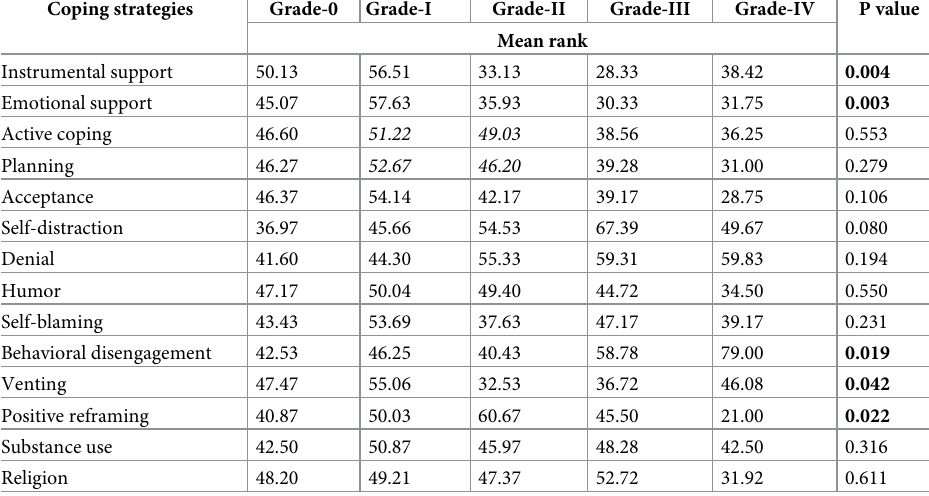
Kruskal-Wallis H test was done; Higher mean rank indicates more adoption of the respective strategy; p value < 0.05 considered as significant.